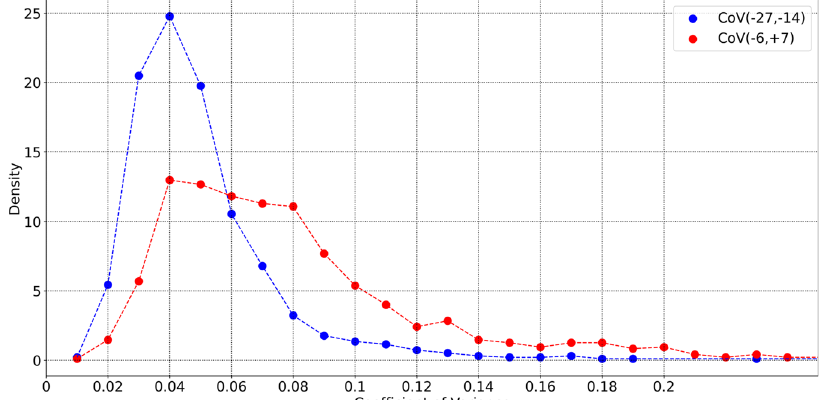
Fig. 6 Distribution of coef fi cient of variance. Distribution of coef fi cient of variance, for symptomatic individuals. The blue points are for the 14 day time window ( D − 27 − D − 14 ), while the red points are computed for the time period ( D − 6 − D + 7 ). We only consider subjects who have at least 10 days of the data in the 14 day window. The curves are normalized to unit